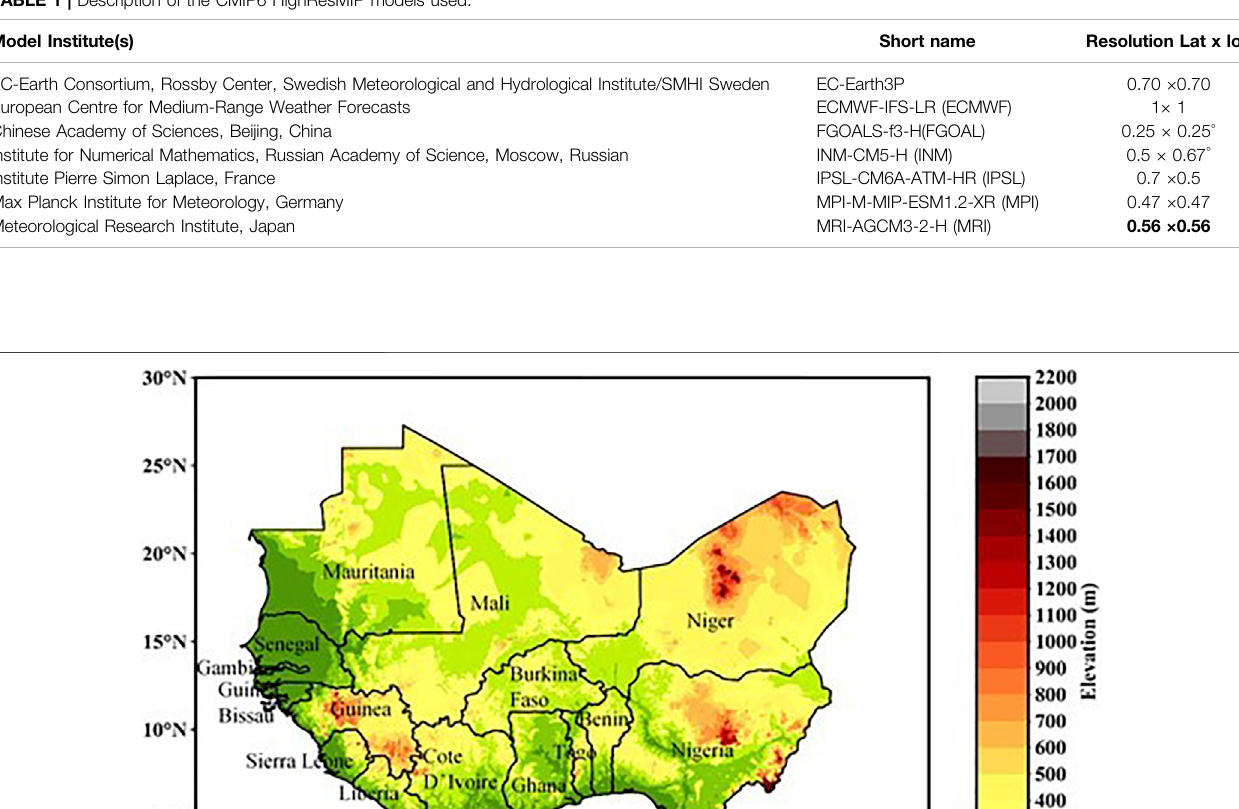
Frontiers in Earth Science |